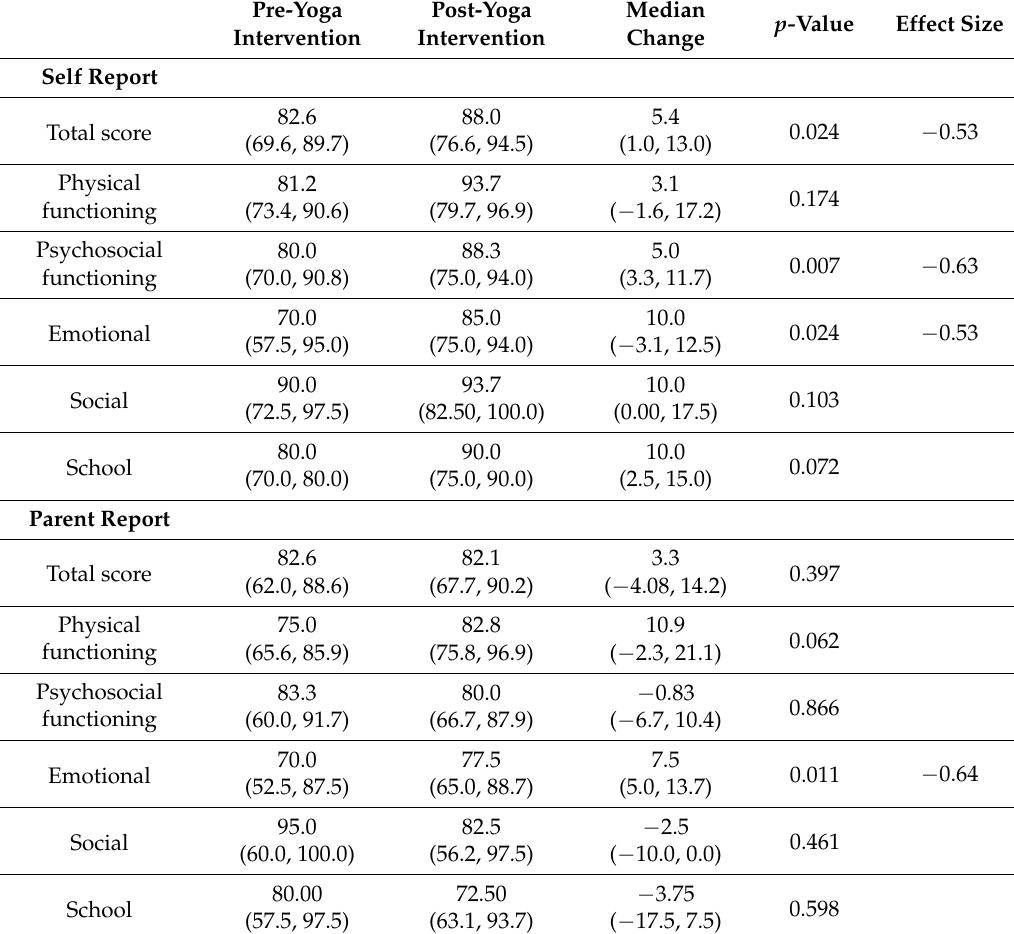
Table 5. Median (IQR) self- and parent-reported HRQoL scores pre- and post-yoga